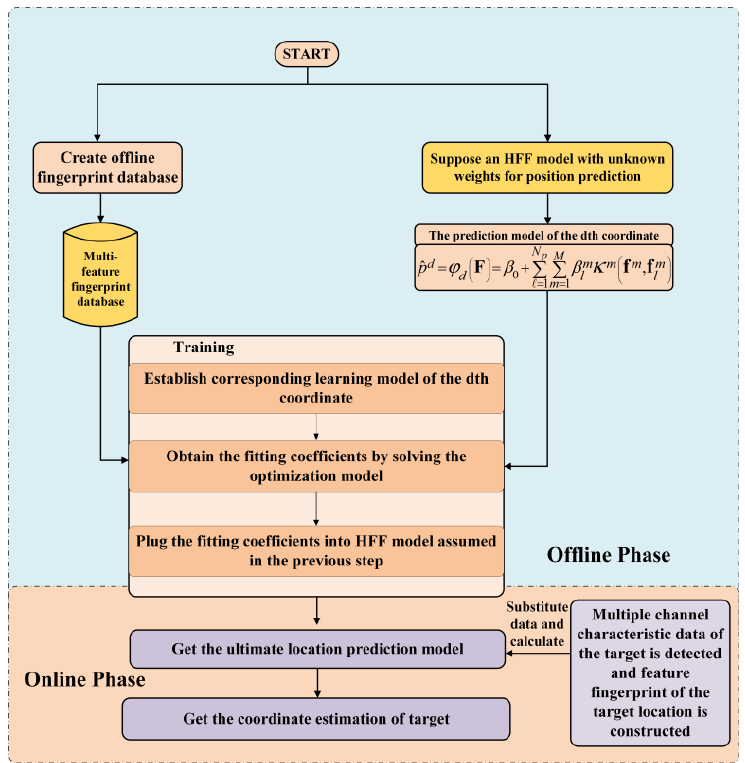
Figure 1. Proposed method for predicting target location in the offline and online phase.